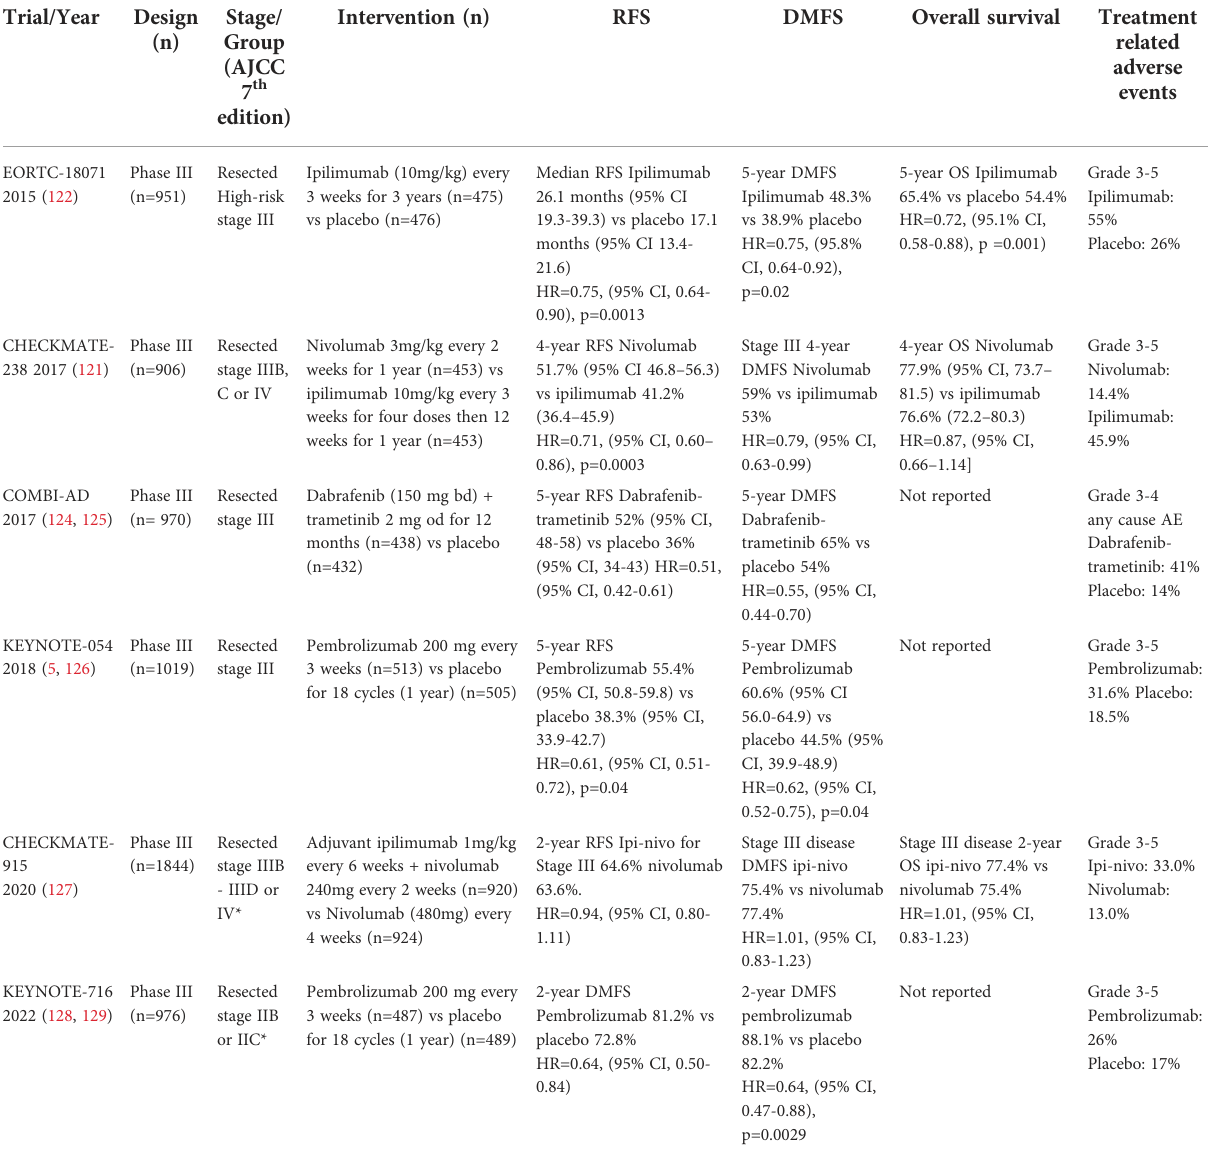
TABLE 2 Clinical trials investigating adjuvant ICIs in resected